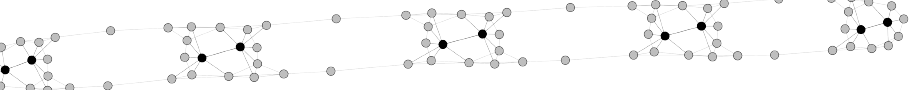
Figure 17. Primal graph of the faulty transmission line model for N = 5 components. Grey vertices represent propositional (edge) variables, while black vertices represent mode